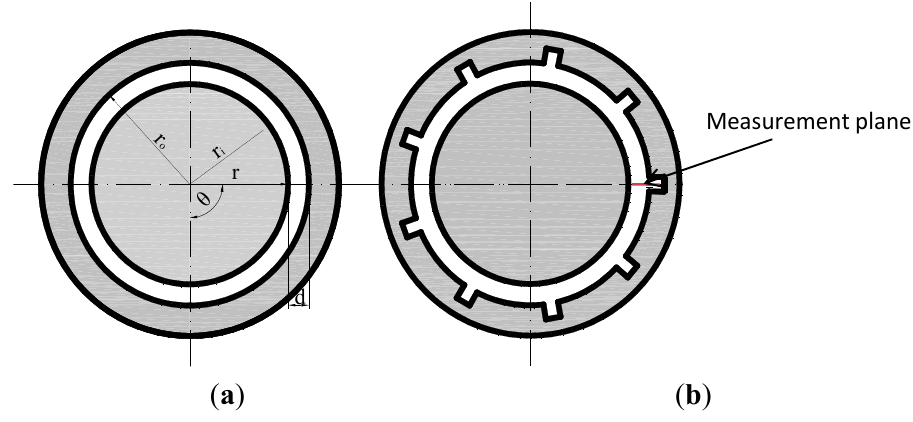
Figure 2. Geometries of models: ( a ) Plain model; and ( b ) 9-Slit